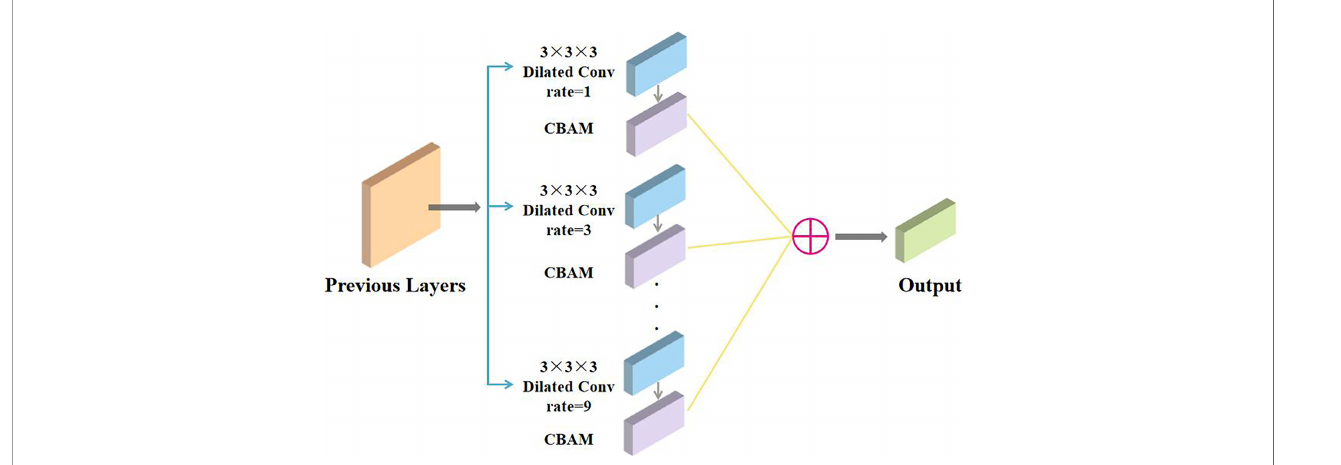
FIGURE 4 | Structure of a DA